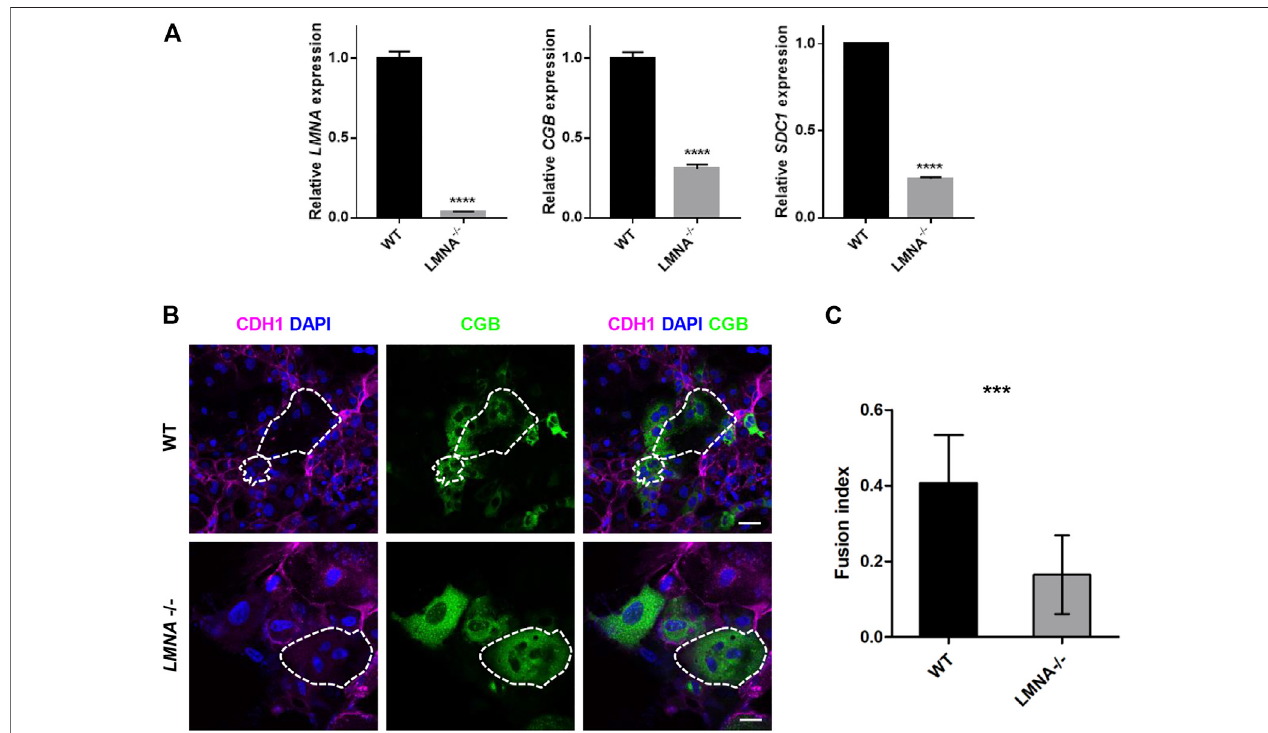
FIGURE5| LossofLMNAinhibited thefusionabilityofhTSCs. (A) qRT-PCRanalysisofLMNA, CGB,SDC1mRNA expressioninWT andLMNA − / − hTSCs.Graph showing the expression level relative to the geometric mean of the housekeeping gene GAPDH. Data are shown as mean ± s.e.m. (B) Immunostaining of WT and LMNA − / − STB for CDH1and CGB. Dotted area represented multinucleated STB. DAPI, blue, DNA. Scale bars, 50 μ m. (C) Quanti fi cation of fusion index in WT and LMNA − / − STB. n = 10 fi elds of view, three experiments. Data are shown as mean ± s.e.m. Unpaired two-tailed Student ’ s t-test, *** p < 0.001. The fusion index was determined by N-S/T, where N was the number of nuclei in STB, S was the number of STB and T was the number of the total number of nuclei.